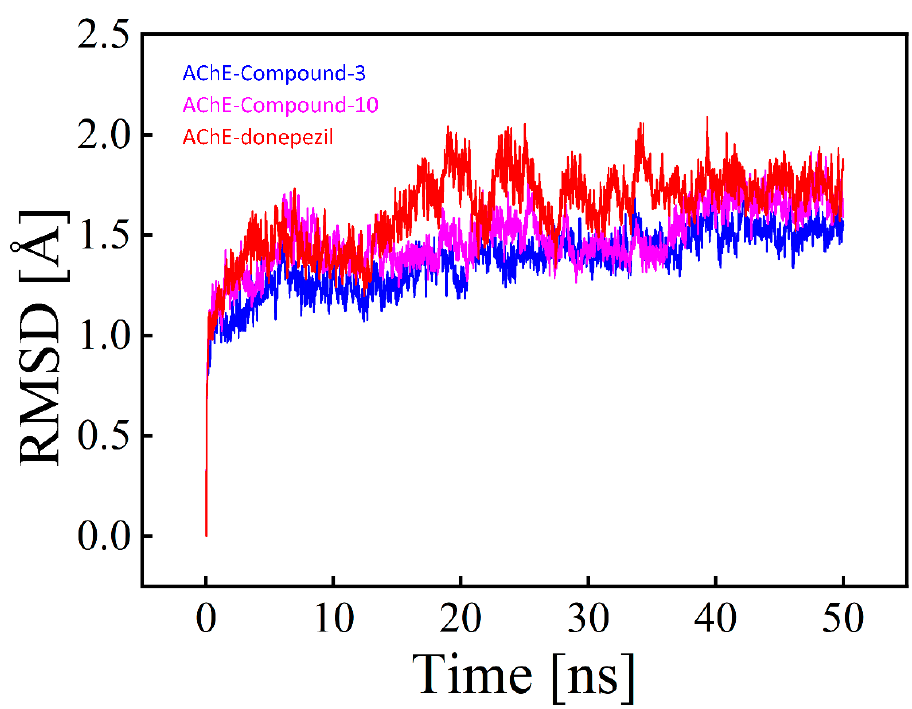
Figure 3. RMSD plot of compound 3 (blue color), compound 10 (magenta color), and donepezil (red color) in complex with AChE.